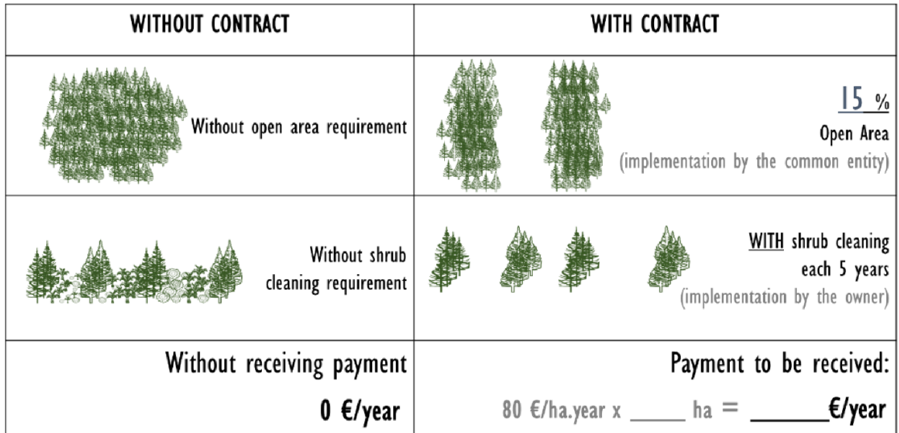
Figure 1. Example of a choice card (to be completed before the choice) according to the area of each respondent).